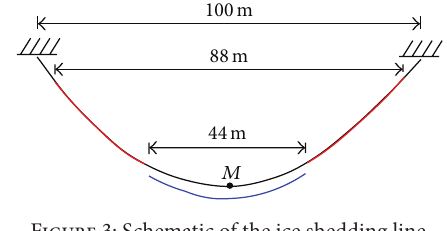
Figure 3: Schematic of the ice shedding line. Table 2: Parameters of GW used in the